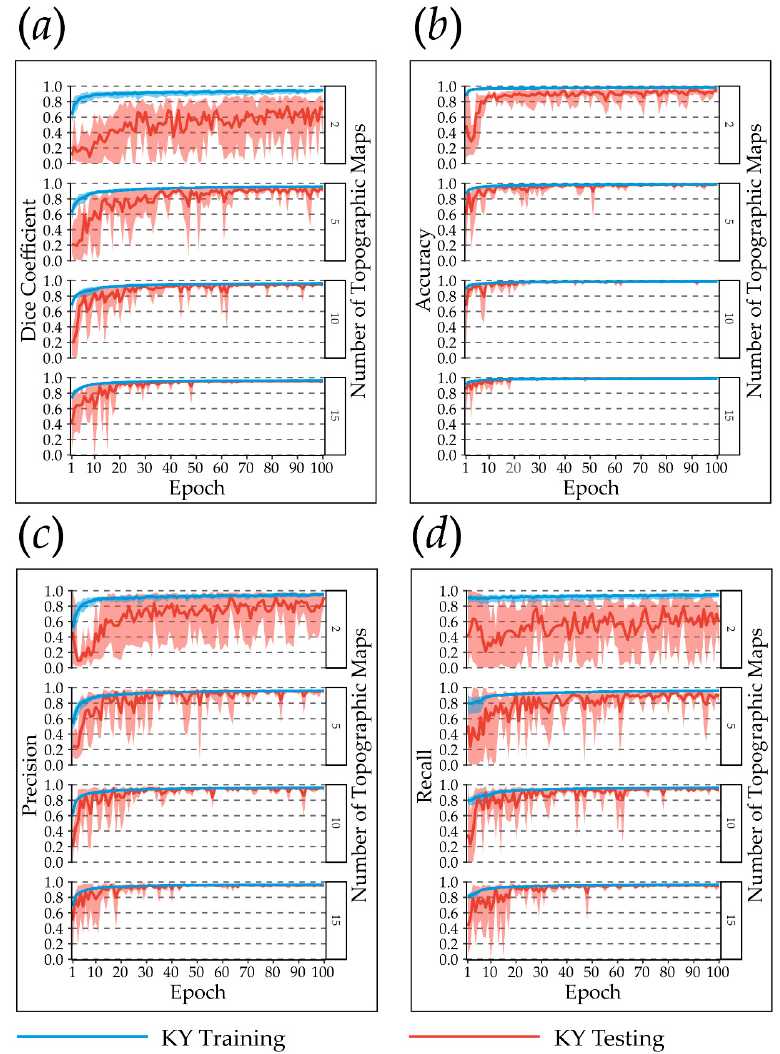
Figure 10. Comparison of accuracy metrics by epoch for the KY Training data and the KY Testing data using subsamples of available topographic maps and associated image chips. Shaded ribbons represent the range of performance of the five models at each epoch. ( a ) Dice coe ffi cient or F1 score, ( b ) overall accuracy, ( c ) precision, and ( d )